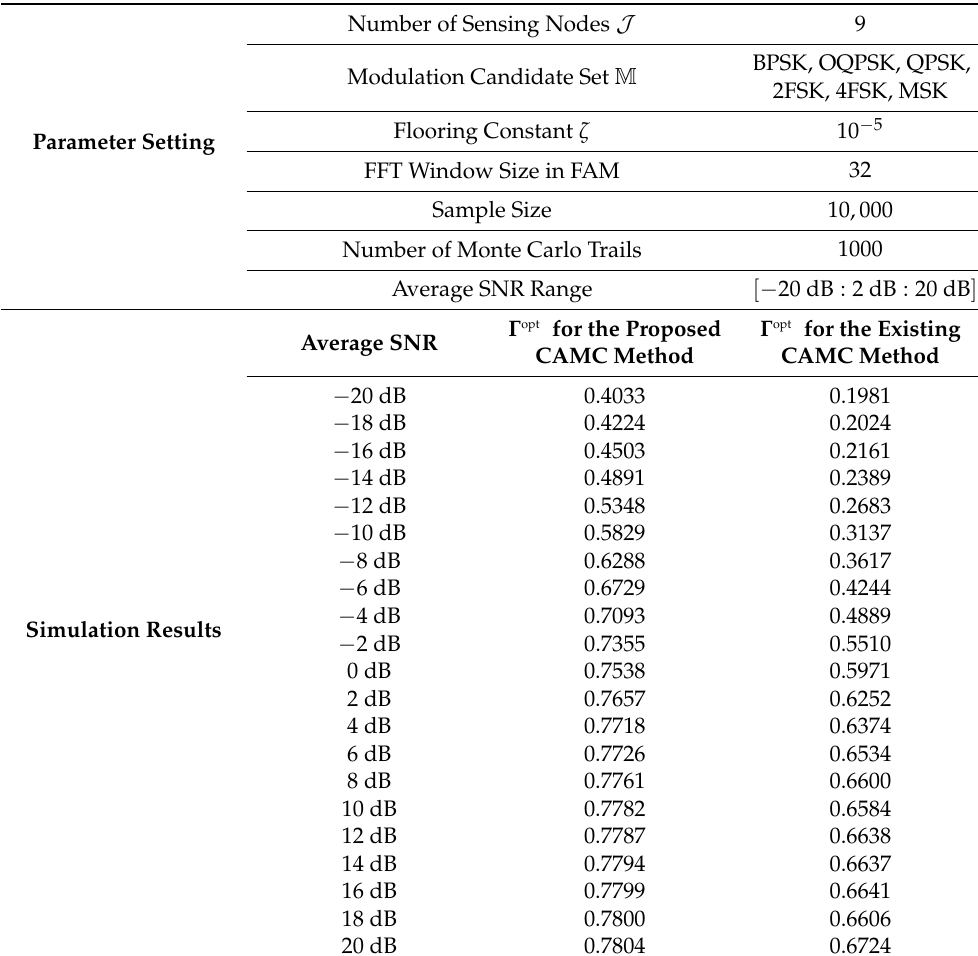
Table 8. The parameter setting and Γ opt resulting from our proposed CAMC approach and the existing CAMC method in